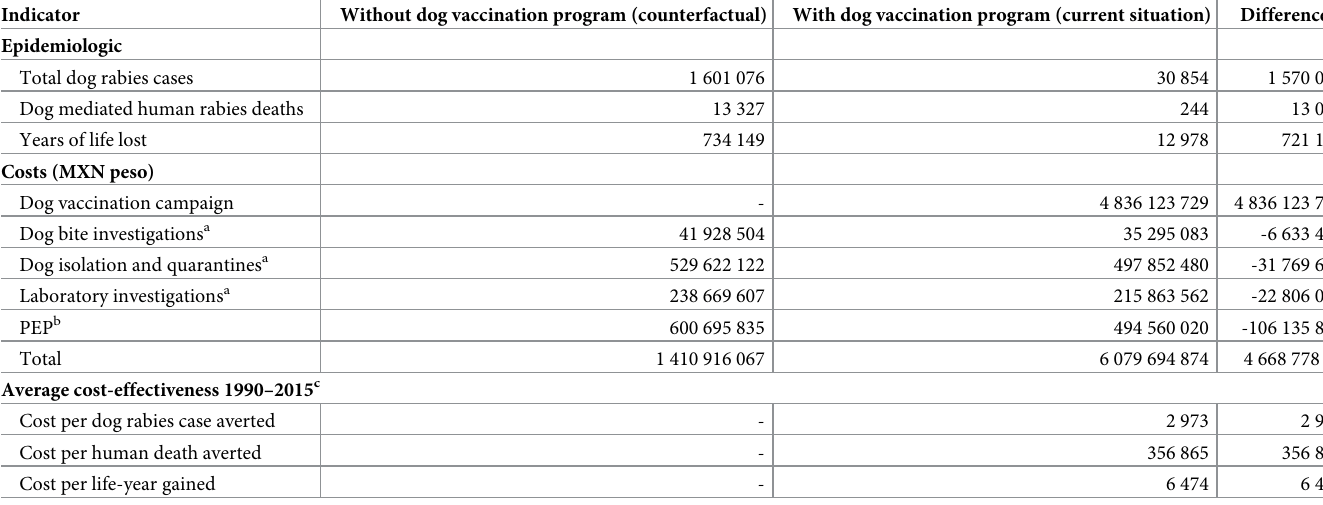
Table 3. Main results for the average cost-effectiveness evaluation of the national program of rabies control in Mexico, 1990–2015 (MXN 2015), compared with an estimated counterfactual scenario without mass dog rabies vaccination program, from the government’s perspective. Indicator Without dog vaccination program (counterfactual) With dog vaccination program (current situation)